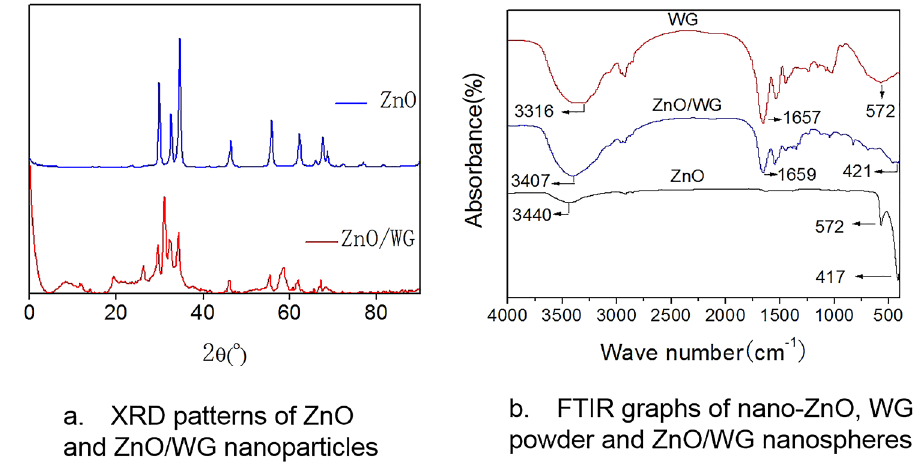
Figure 2. XRD patterns ( a ) and FTIR graphs ( b